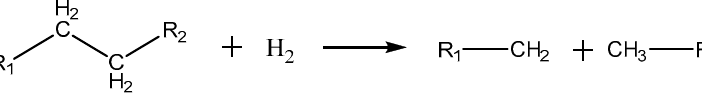
Figure 4. The general reaction pathway for hydrocracking. Reprinted from reference [40].